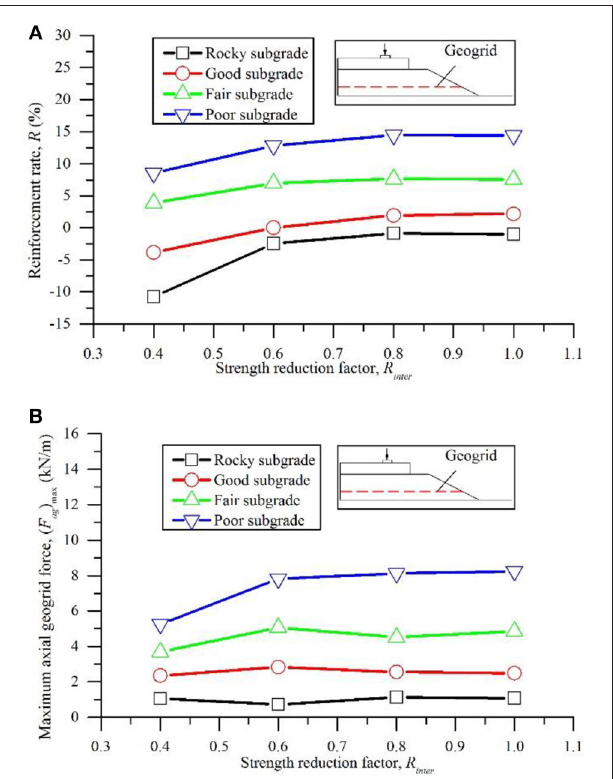
FIGURE 8 | Reinforcement rate and maximum axial force in geogrids with respect to the factor of geogrid layers (Case 6): (A) reinforcement rate; (B) maximum axial geogrid